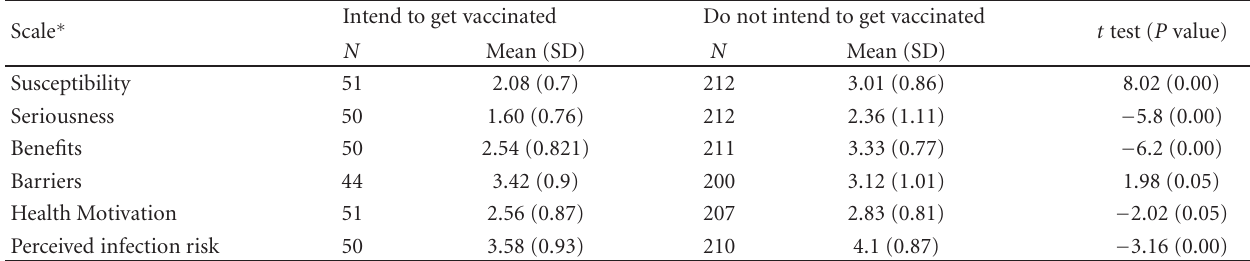
Table 5: Mean values of Health Belief Model (HBM) measures by intention to get the swine flu shot in the next year.